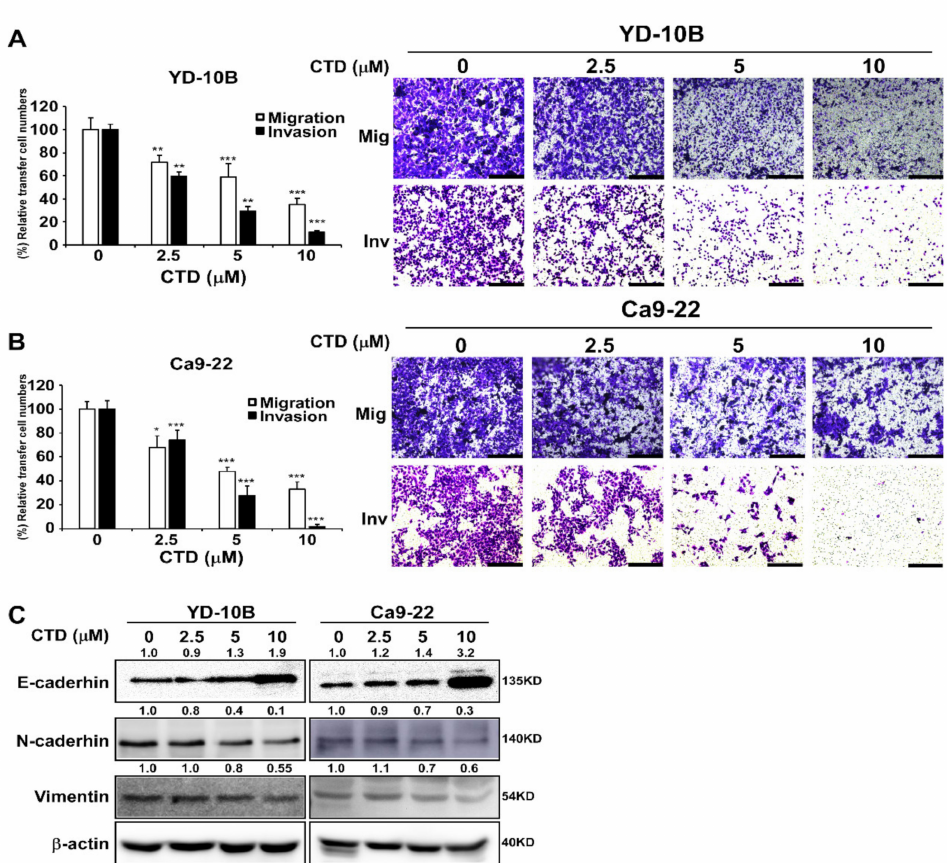
Figure 4. Costunolide inhibits the migration and invasion of oral cancer cells. ( A ) The migration and invasion of YD-10B cells was examined by the transwell membrane with or without the Matrigel assay after treatment with different doses of CTD at 24 h and representative photographs (Scale bar = 200 µ m). ( B ) The migration and invasion of Ca9-22 cells was determined by the transwell membrane with or without the Matrigel assay after treatment with different doses of CTD at 24 h and representative photographs (Scale bar = 200 µ m). Data are expressed as mean ± SD of values from triplicate samples. * p < 0.05, ** p < 0.01 and *** p < 0.001 indicate a significant difference compared with control. ( C ) The expression levels of E-cadherin, N-cadherin and vimentin were detected by western blotting after treatment with